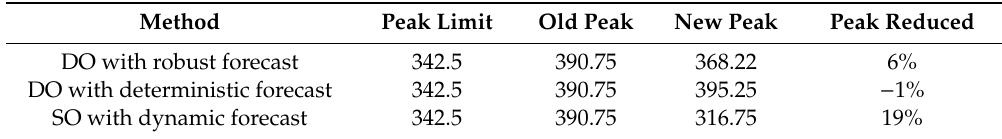
Figure 10. PEVs’ schedule on observed demand using the Day ahead probabilistic demand forecast and DO. Table 2. Algorithms performance comparison.